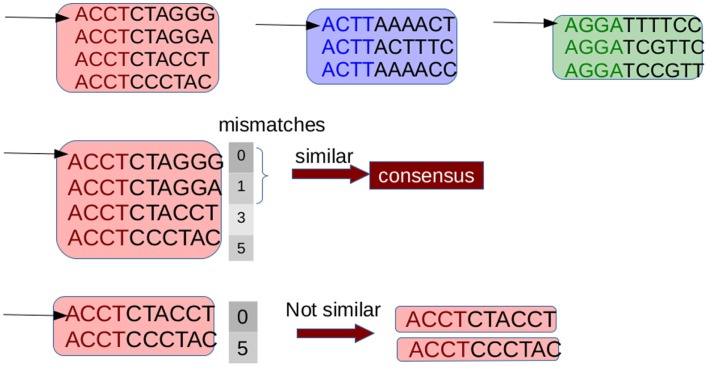
Suffixes of sequences in a cluster are compared to identify the duplicates. The first read is taken as a seed and its suffix is compared with those of the other ones. Sequences with a number of mismatches lower than a given threshold are considered duplicates of the seed. These sequences are removed from the cluster and are represented with a consensus sequences. Then the process is repeated until the cluster is empty or consists of a single sequence.